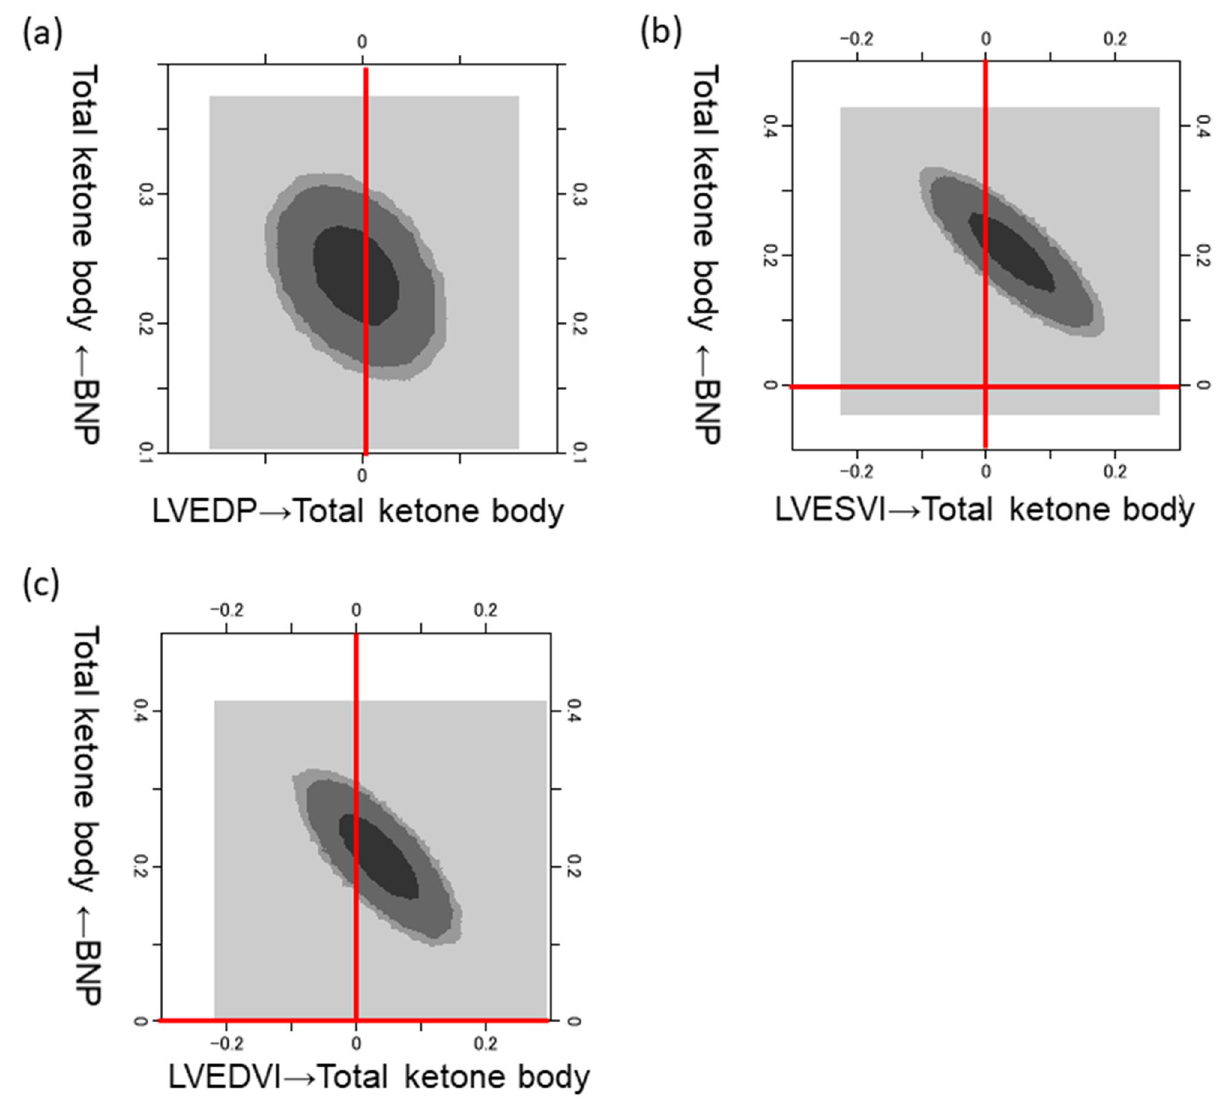
Figure 3. Bayesian structure equation modeling. Frequency polygons were described by the marginal posterior distributions of the estimates. The two-dimensional plot of the bivariate posterior density shows the relationship between the bivariate marginal posterior plots. From light to dark, the 3 shades of gray represent 50%, 90%, and 95% reliable regions, respectively. BNP B-type natriuretic peptide, LVEDP left ventricular end-diastolic pressure, LVESVI left ventricular end-systolic volume index, LVEDVI left ventricular end-diastolic volume